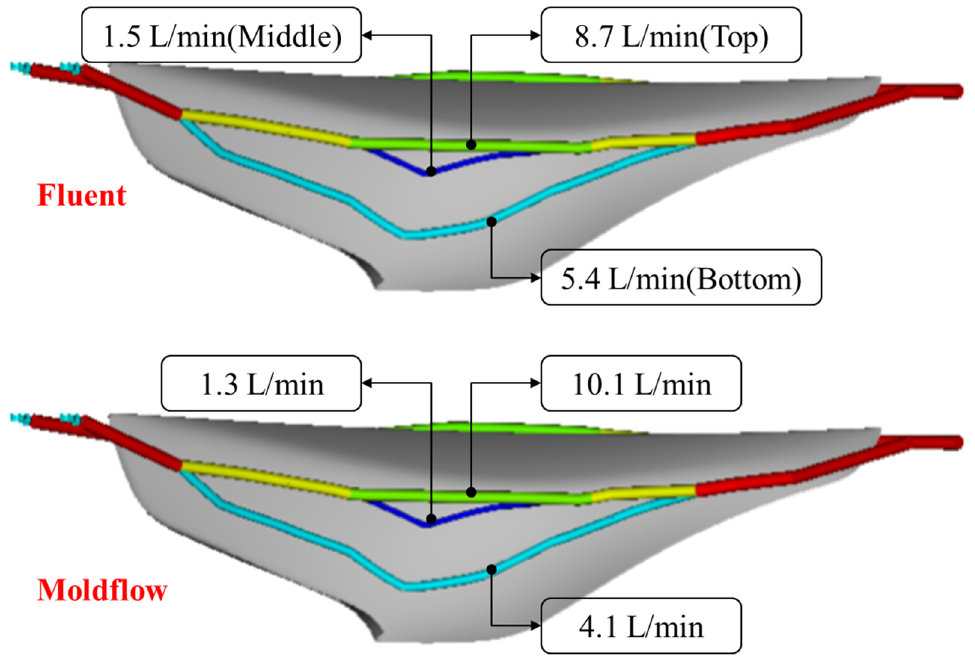
Figure 15. Flow comparison through Moldflow and Fluent analysis in the third generation of cooling channel at the core side.